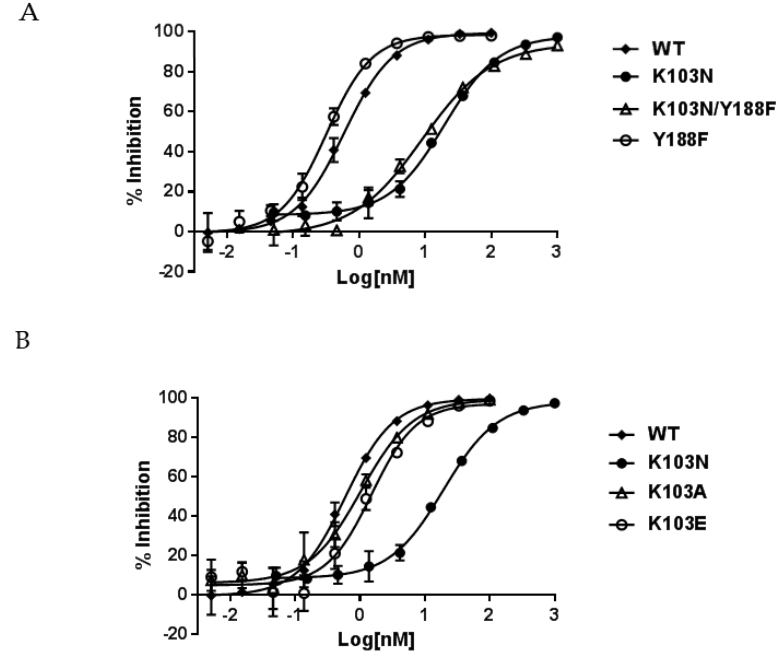
Figure 2. Inhibition curves of efavirenz (EFV) against K103 variants and/or Y188F RTs. ( A ) Wild type (WT) RT, K103N RT, Y188F RT, and K103N/Y188F RT; ( B ) WT RT, K103N RT, K103E RT, and K103A RT. The error bars are in means ± standard deviation with greater than three replicates.